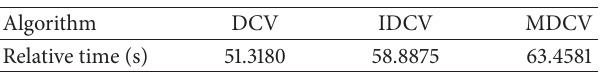
of IDCV algorithm, but better than that of DCV algorithm. Table 3: The comparison of retrieval time among MDCV, DCV, and IDCV